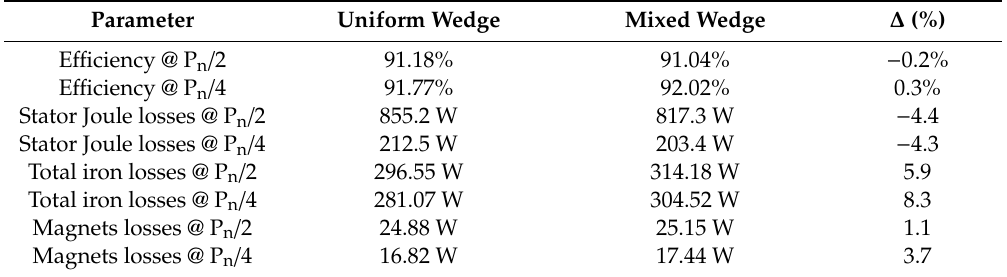
Table 6. E ffi ciencies, Joule losses, iron losses, and magnets losses at low loads. Parameter Uniform Wedge Mixed